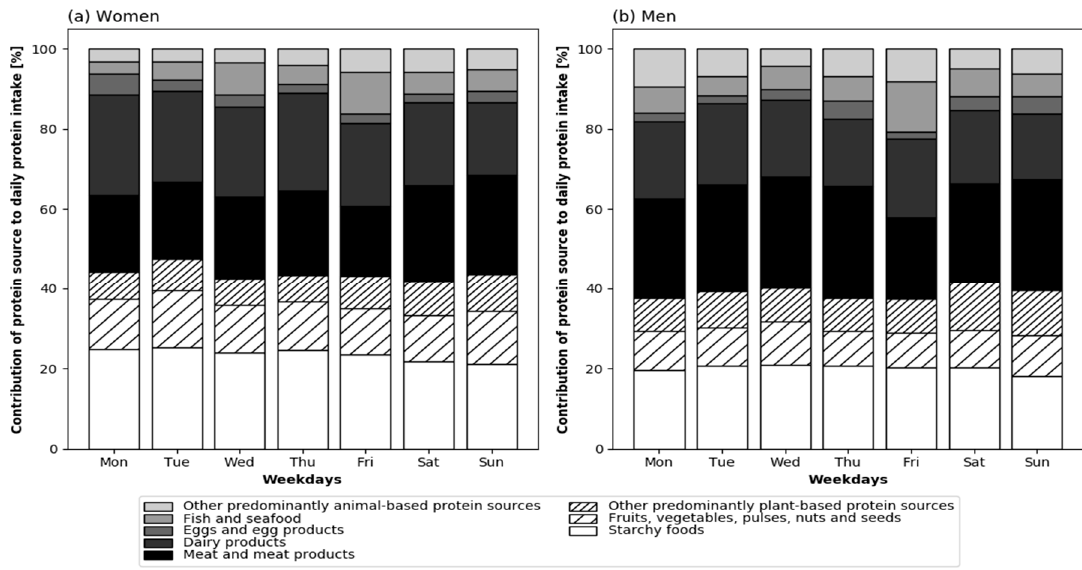
Figure 5. Contribution of protein sources to protein intake by weekday in healthy community-dwelling older women ( n = 72) and men ( n = 68). Mean is presented. Friedman’s test: egg and egg products: p = 0.033 in women, p = 0.012 in men, fish and seafood: p = 0.004 in women. For all other protein sources p ≥ 0.05.